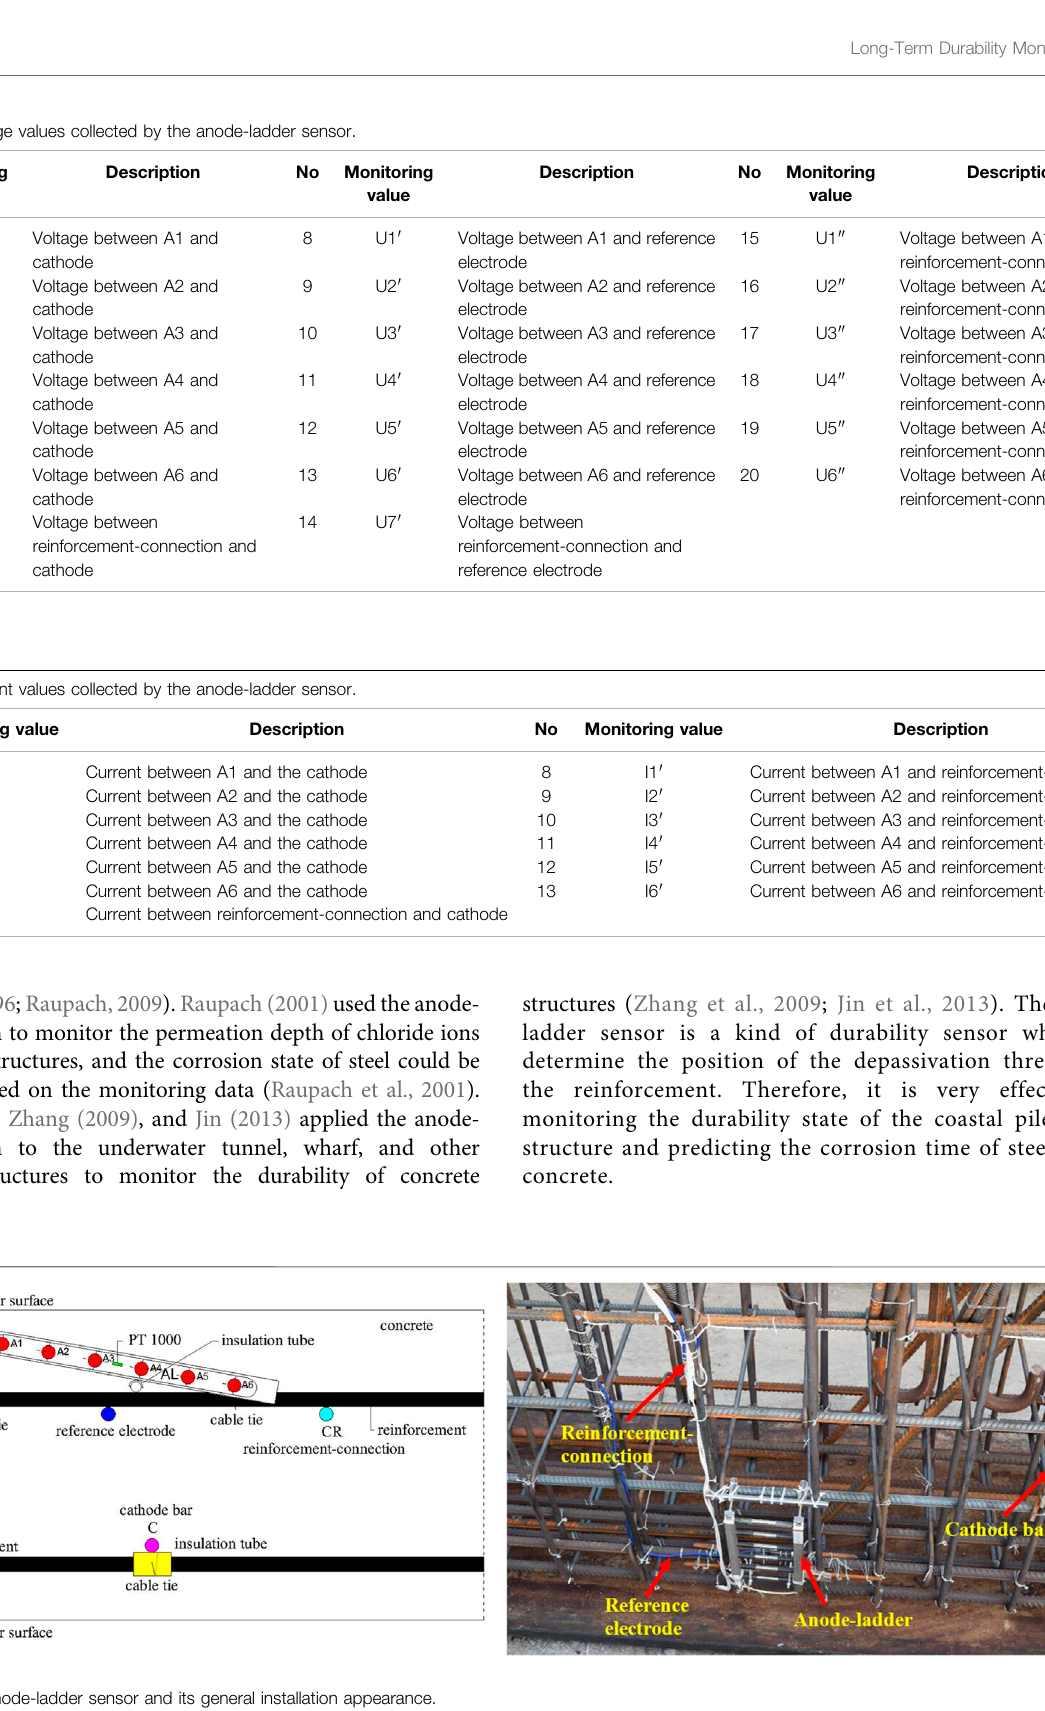
FIGURE 3 | Anode-ladder sensor and its general installation appearance.